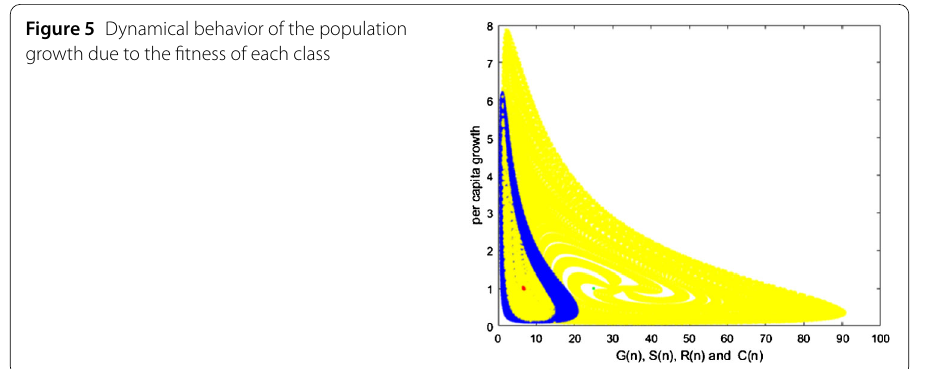
Figure 5 Dynamical behavior of the population growth due to the fitness of each